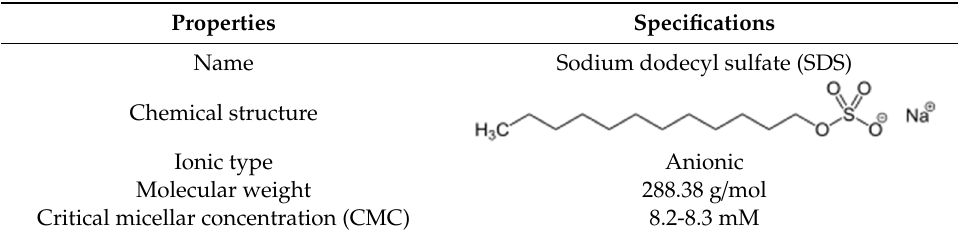
Table 2. Properties of the surfactant used in this study.